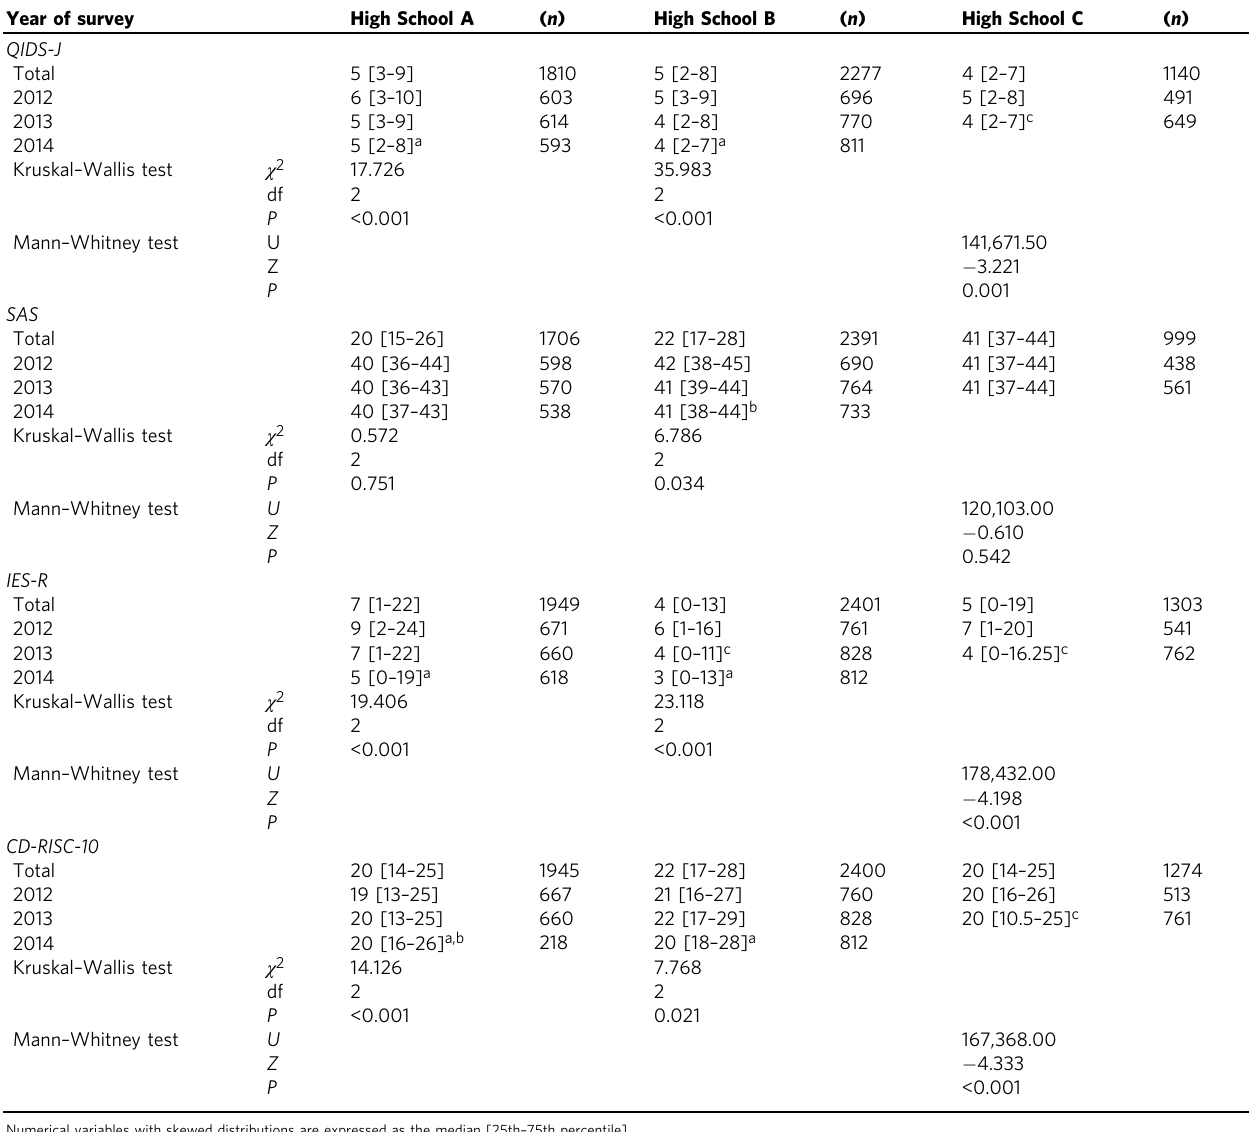
Table 1 Resilience and mental health indicators of students assessed from 2012 to 2014. Year of